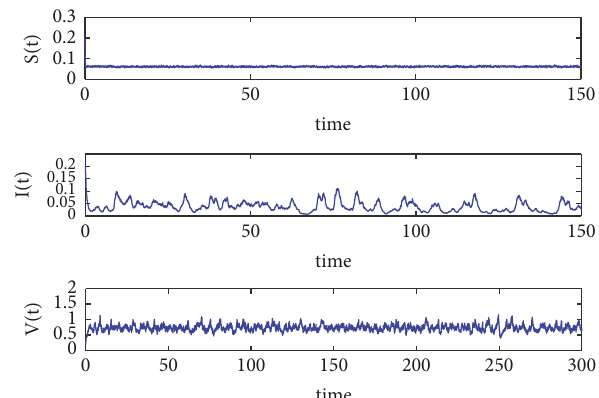
Figure 1: Simulation of the paths 𝑆(𝑡),𝐼(𝑡) , and 𝑉(𝑡) for model